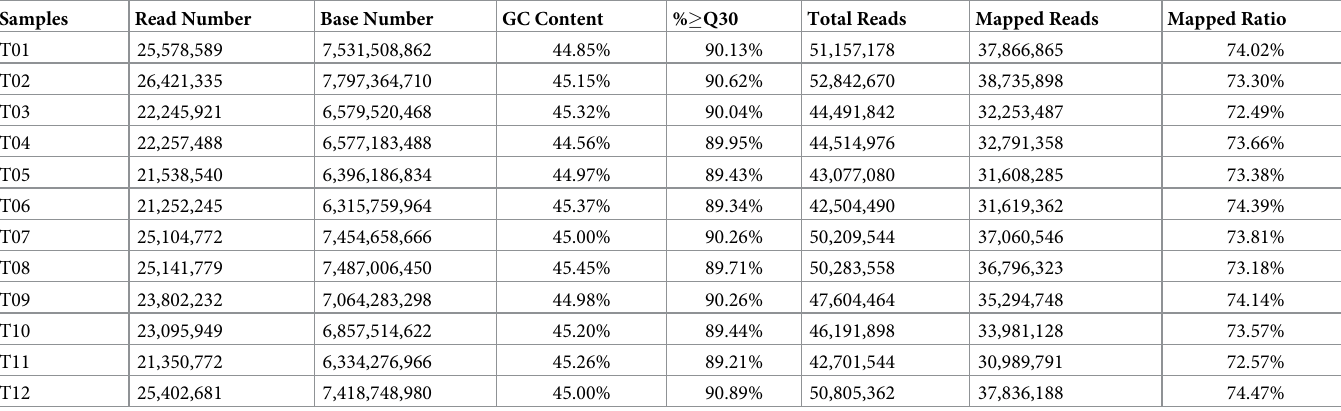
Table 1. Evaluation and genome-wide comparison of sequencing